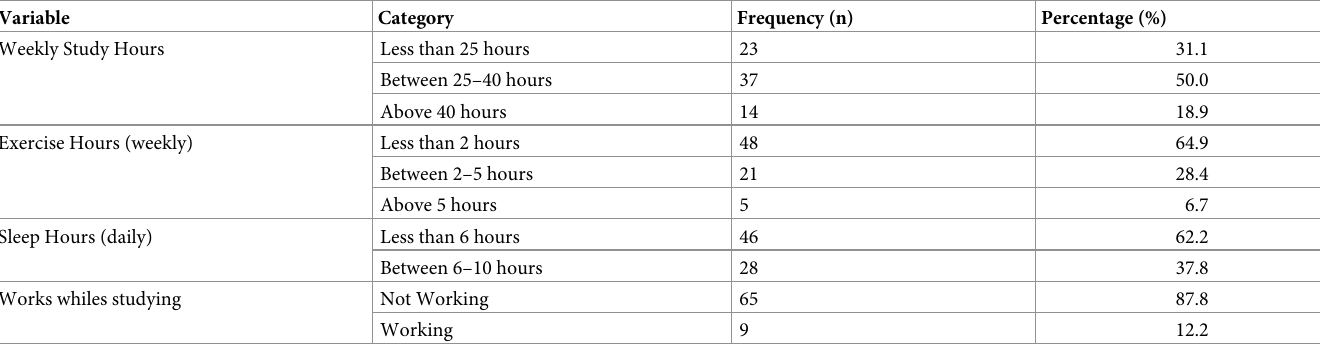
Table 2. Results of practices of